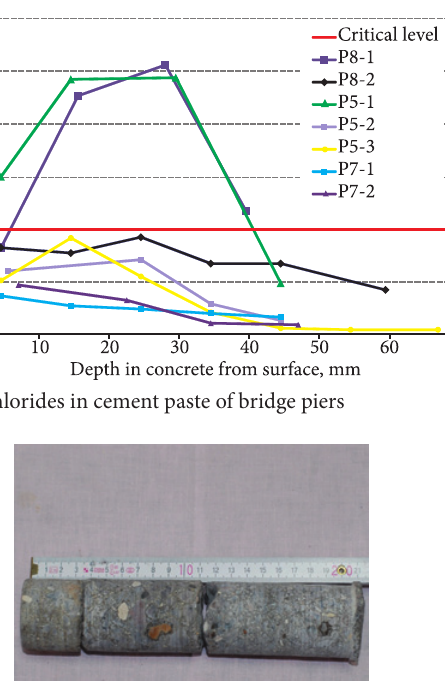
fig. 12. Core sample from the web of the beam near leaking expansion joint